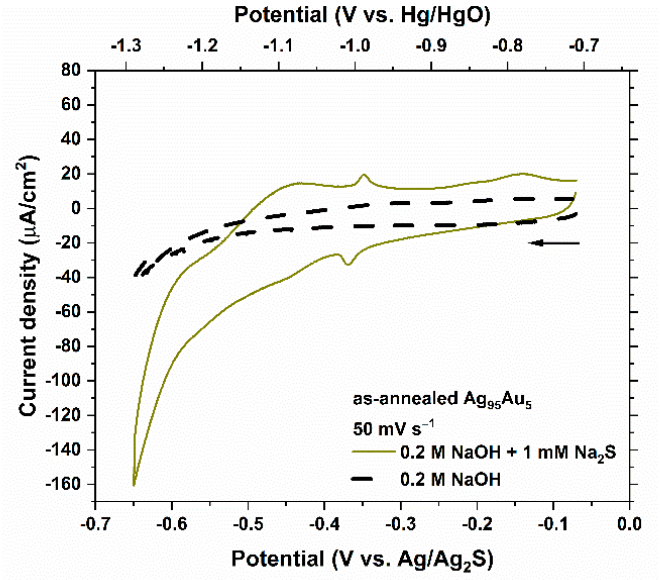
Figure 4. Cyclic voltammetry of an as-annealed (non-dealloyed) Ag 95 Au 5 alloy (0.25 cm 2 ) in 0.2 M NaOH solution with and without 1 mM Na 2 S at a scan rate of 50 mV s − 1 . The arrow indicates the starting point and the scan direction.